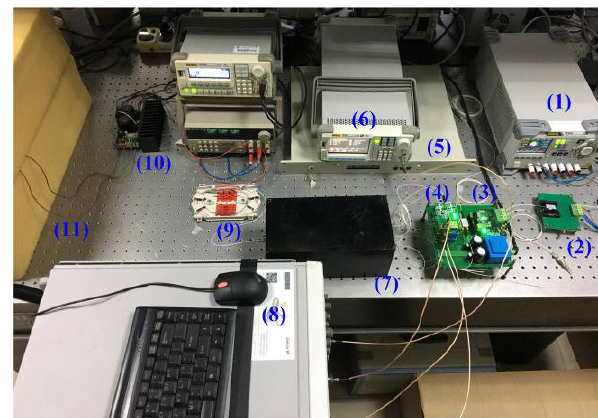
Fig. 6 Experimental rig of our distributed optical fiber